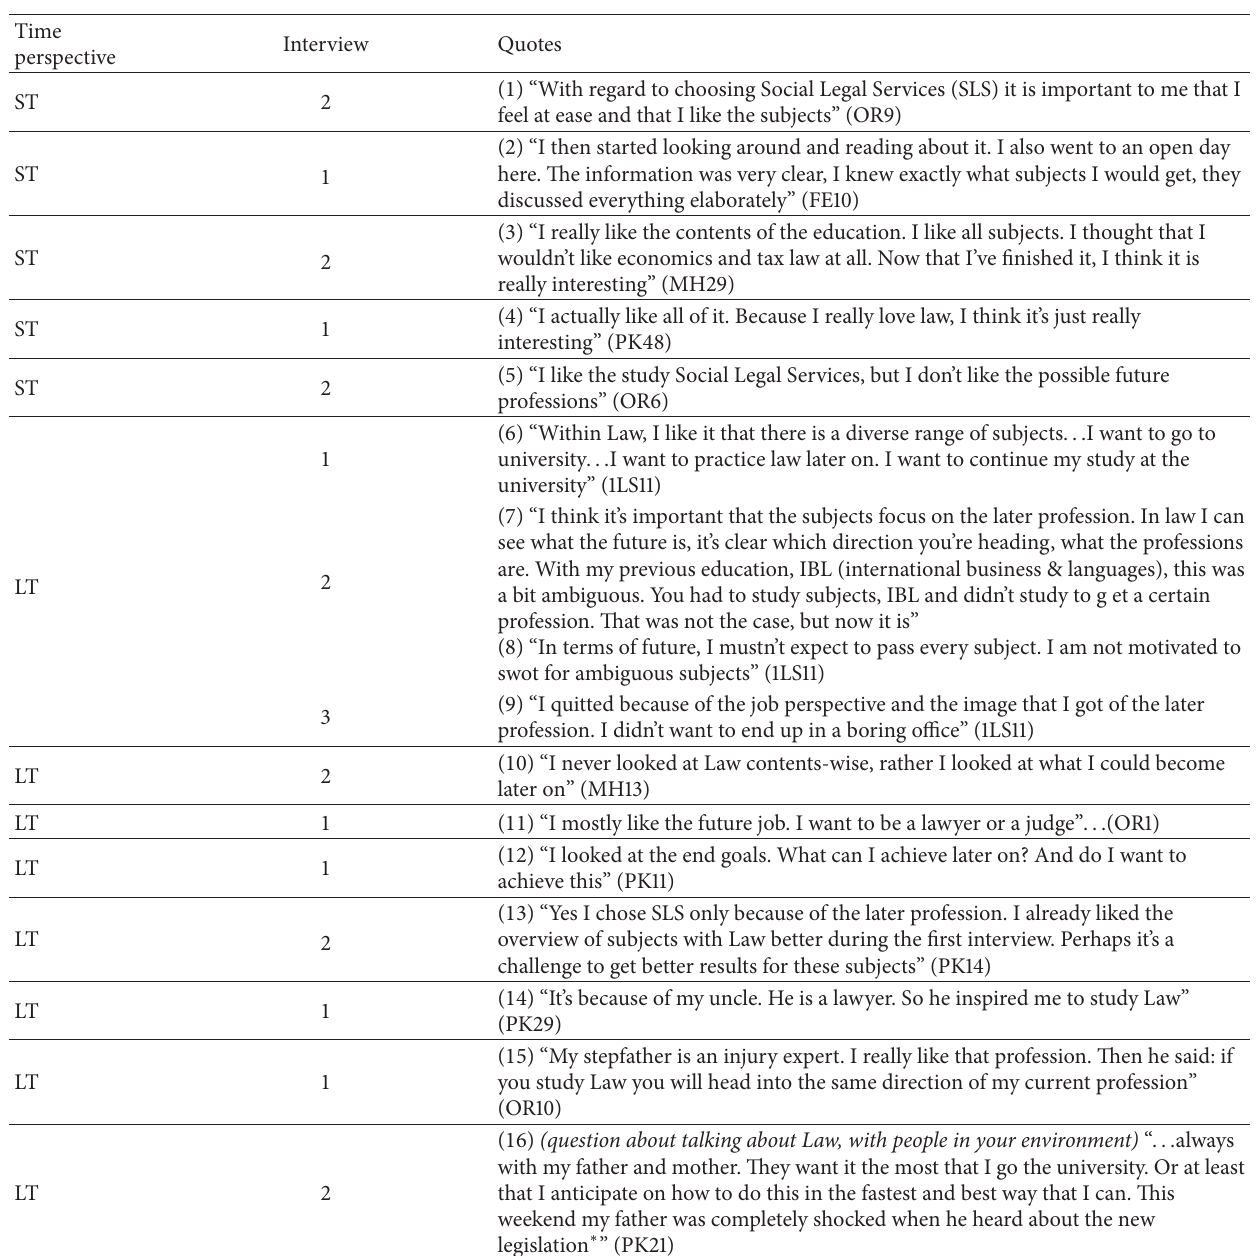
Table 2: Quotes about time perspective in the higher education choice